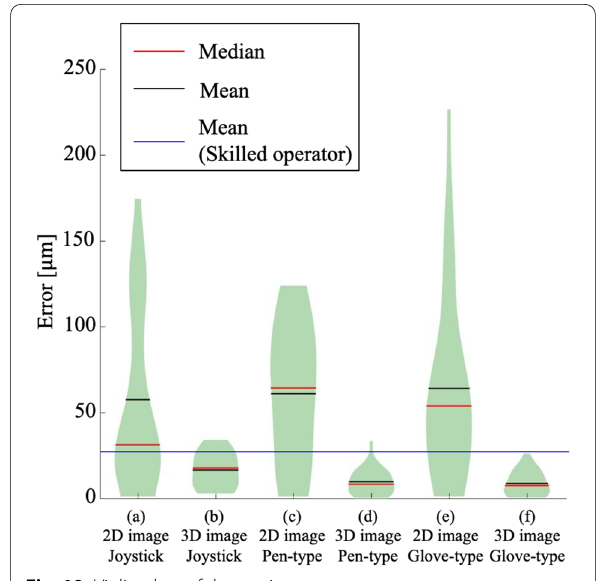
Fig. 19 Violin plots of the z -axis error